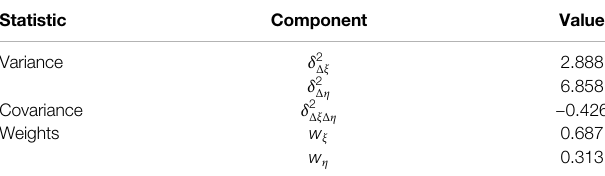
TABLE 3 | Variances, covariance and weights of vertical de fl ection components.